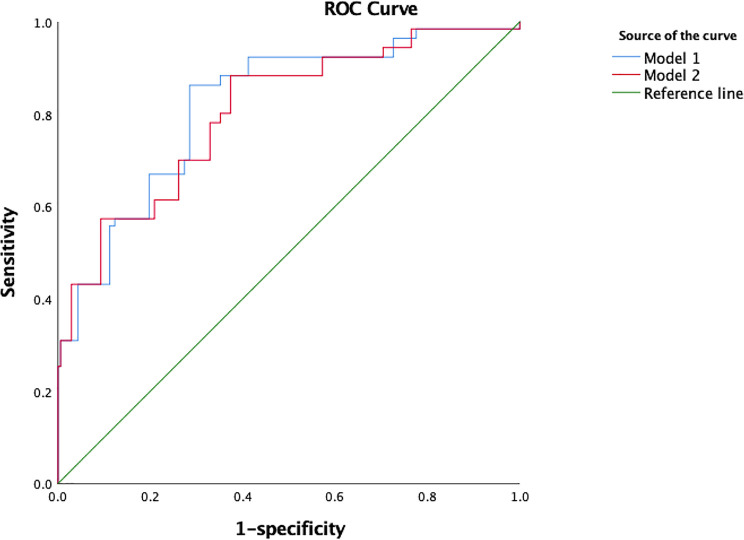
The ROC curve of model 1 and model 2 for predicting CI-AKI.